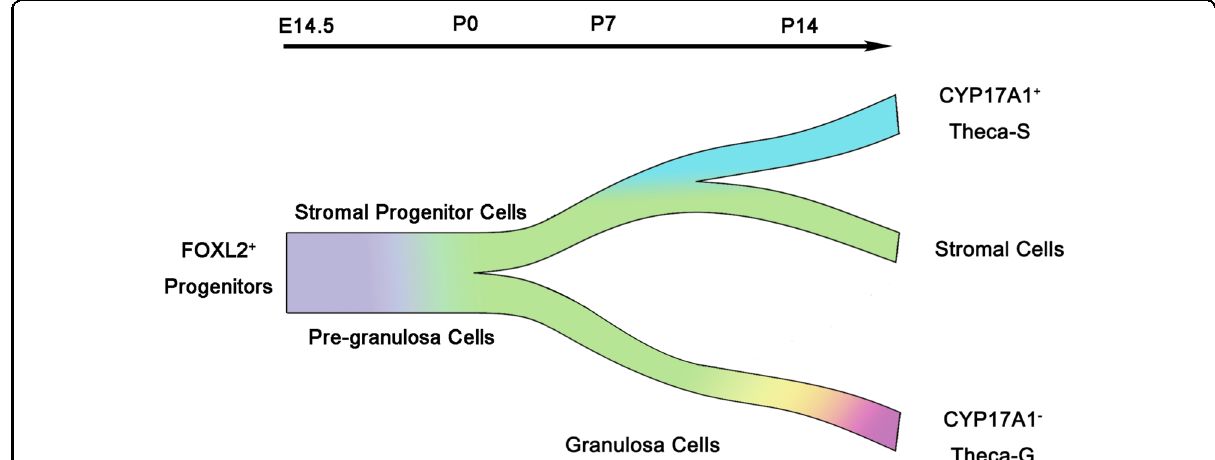
Fig. 7 Schematic image of the FOXL2 + cell lineage reconstruction during ovary development. FOXL2 + progenitor cells in the fetal ovary give rise to stromal cells, CYP17A1 + Theca-S, granulosa cells, and CYP17A1 − Theca-G. A subset of FOXL2 + progenitor cells acquire stromal cell fate at P0, and then a small portion of these early stromal cells gradually differentiate as CYP17A1 + Theca-S between P7 and P14. The rest of the progenitor cells differentiate as pre-granulosa cells at P0. Pre-granulosa cells maintain their granulosa cell fate and become granulosa cells, and then CYP17A1 − Theca-G are gradually derived from granulosa